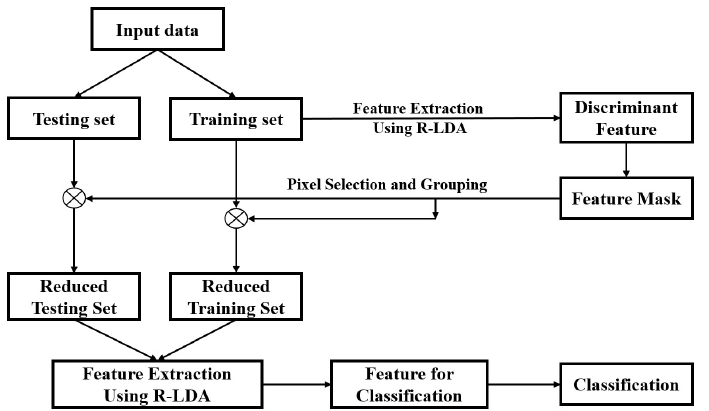
Figure 3. Overall procedure of the R-LDA-based feature